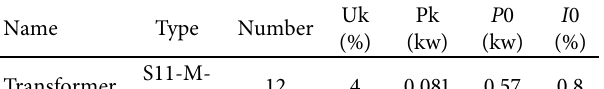
Figure 5: 10 kV feeder topology.